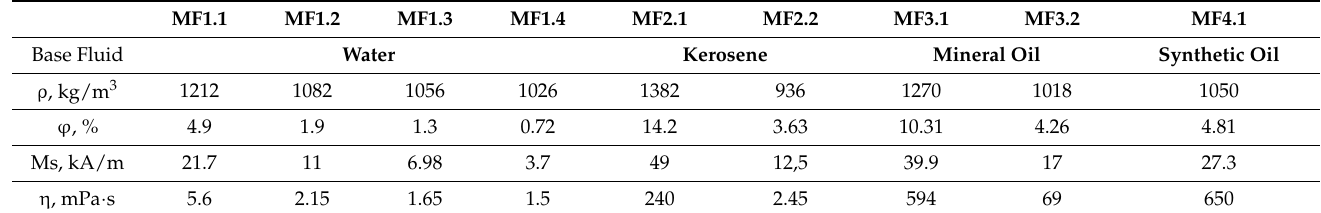
Table 1. Physical parameters of the MF.